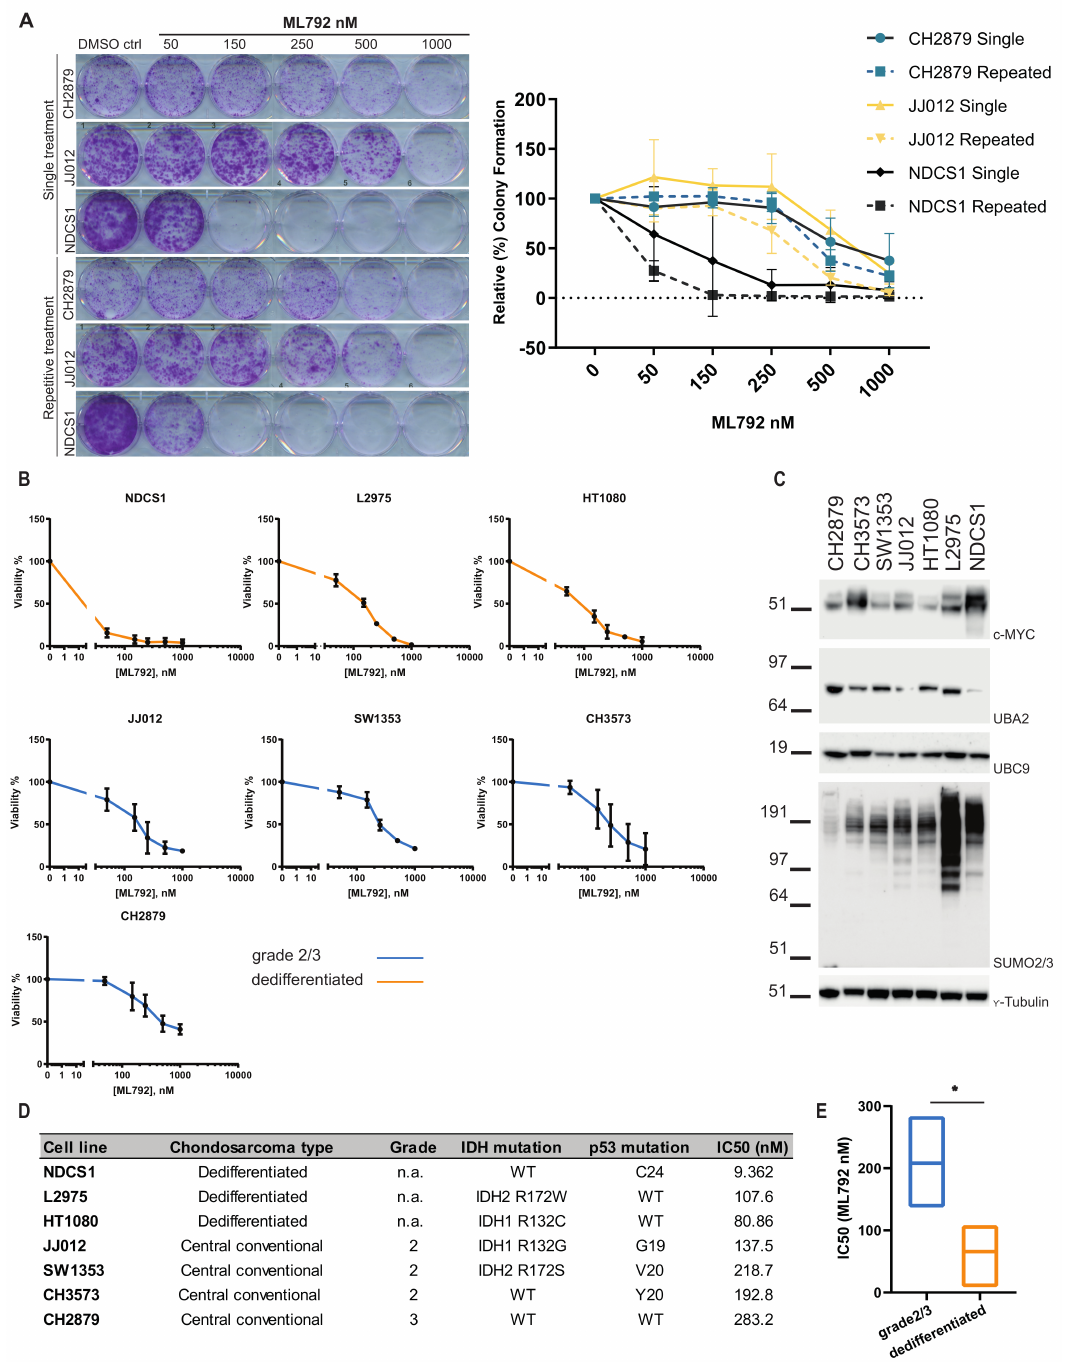
Figure 3. Inhibition of SUMO E1 via ML792 results in decreased proliferative capacity and cell viability. ( A ) Two-dimensional (2D) colony-formation assay (crystal violet). CH2879, JJ012, and NDCS1 cells were treated with ML792 cells using single treatment or repetitive treatment on day 1, 4, 7, and 10 after seeding. Colony-formation was quantified via measuring crystal violet staining. Data represent mean with standard deviation ( n = 3). ( B ) Viability assay using PrestoBlue. Chondrosarcoma cell lines were treated with ML792 and incubated for 3 days. Relative cell viability is represented as mean with standard deviation ( n = 3). ( C ) Expression levels of c-MYC, UBA2, UBC9 and conjugation of SUMO2/3 in lysates of untreated chondrosarcoma cell lines from Figure 3C. Υ -tubulin was used as loading control. Single representative images are shown ( n = 3). Whole blots including intensity readings can be found in Figure S5 ( D ) Table displaying specifics of the cell lines from B including IC50 (nM) values. ( E ) Boxplots to compare IC50 values of dedifferentiated ( n = 3) and grade 2/3 ( n = 4) chondrosarcoma cell lines. Significance was calculated with a two-tailed t -test *: p <